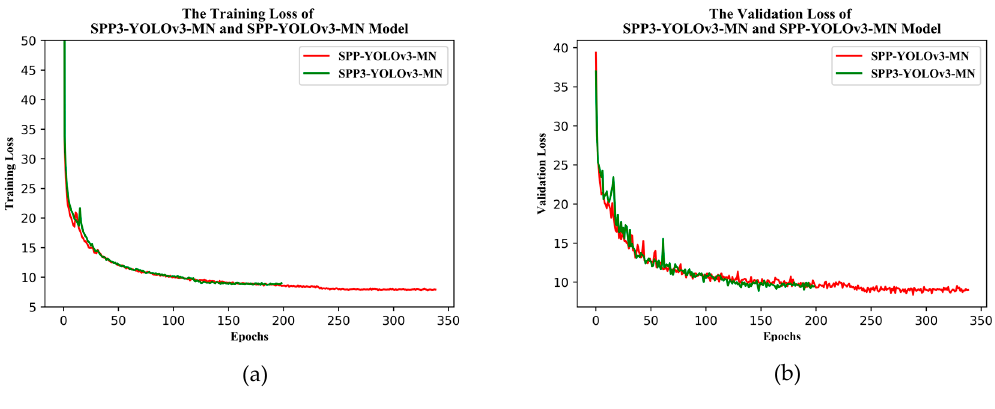
Figure 17. ( a ) Training and ( b ) validation losses for the SPP3-YOLOv3-MN and SPP-YOLOv3-MN models.